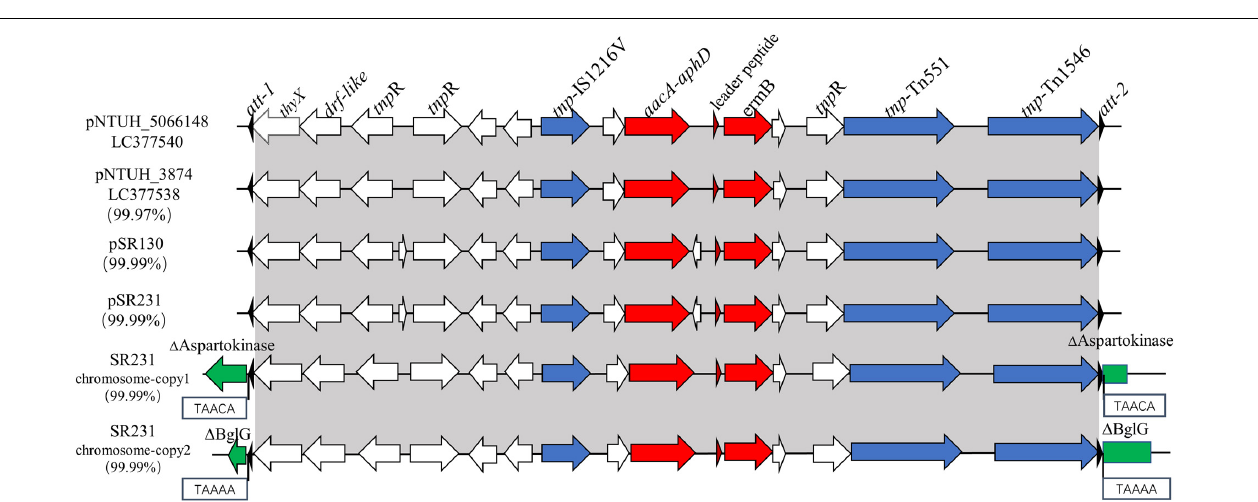
FIGURE 2 | Genetic structures of ermB -positive Tn1546-like elements in pSR130, pSR231 and in two different positions of the SR231 chromosome and structural comparison with pNTUH_3874 and pNTUH_5066148. thyX , thymidylate synthase; drf-like , dihydrofolate reductase; ermB , conferring resistance to erythromycin; aacA- aphD, conferring resistance to